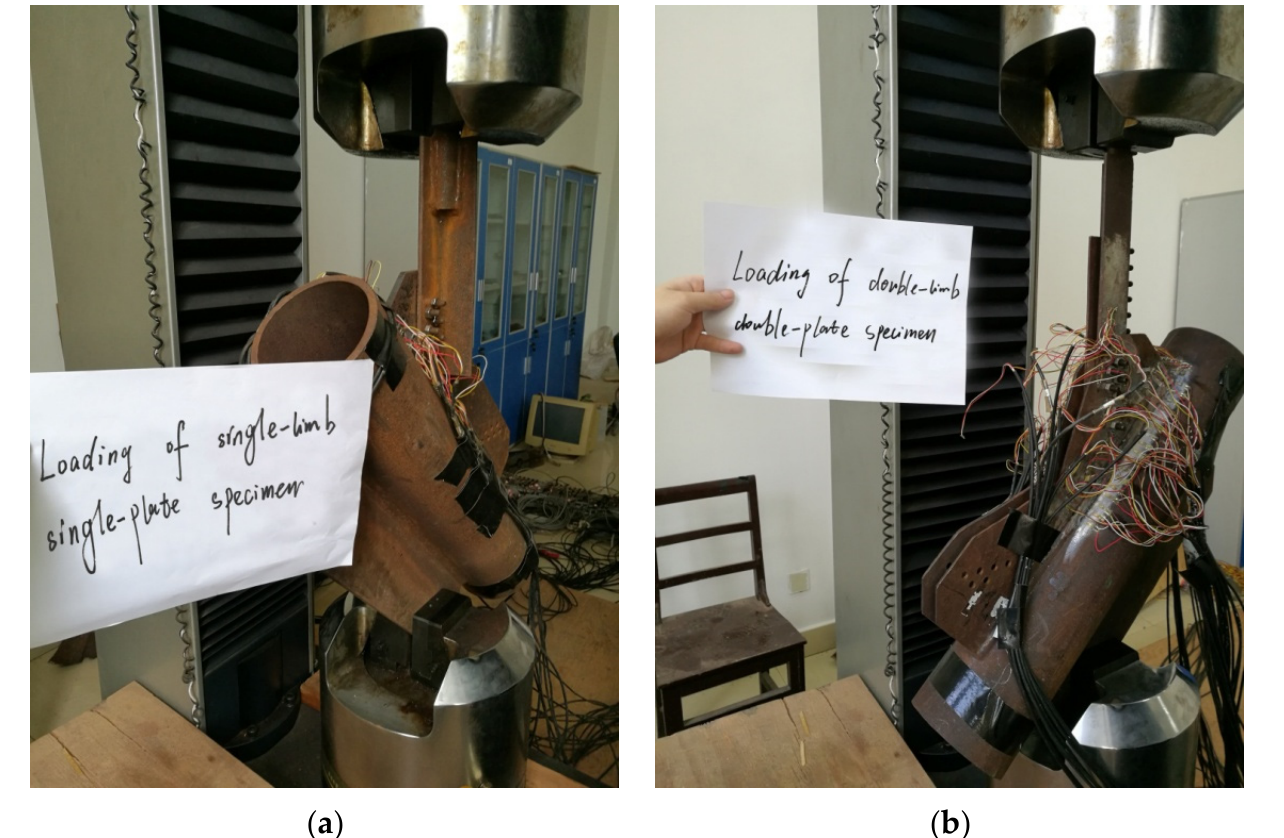
Figure 6. ( a ) Loading device for test piece of SLSPJ; ( b ) loading device for test piece of DLDPJ.